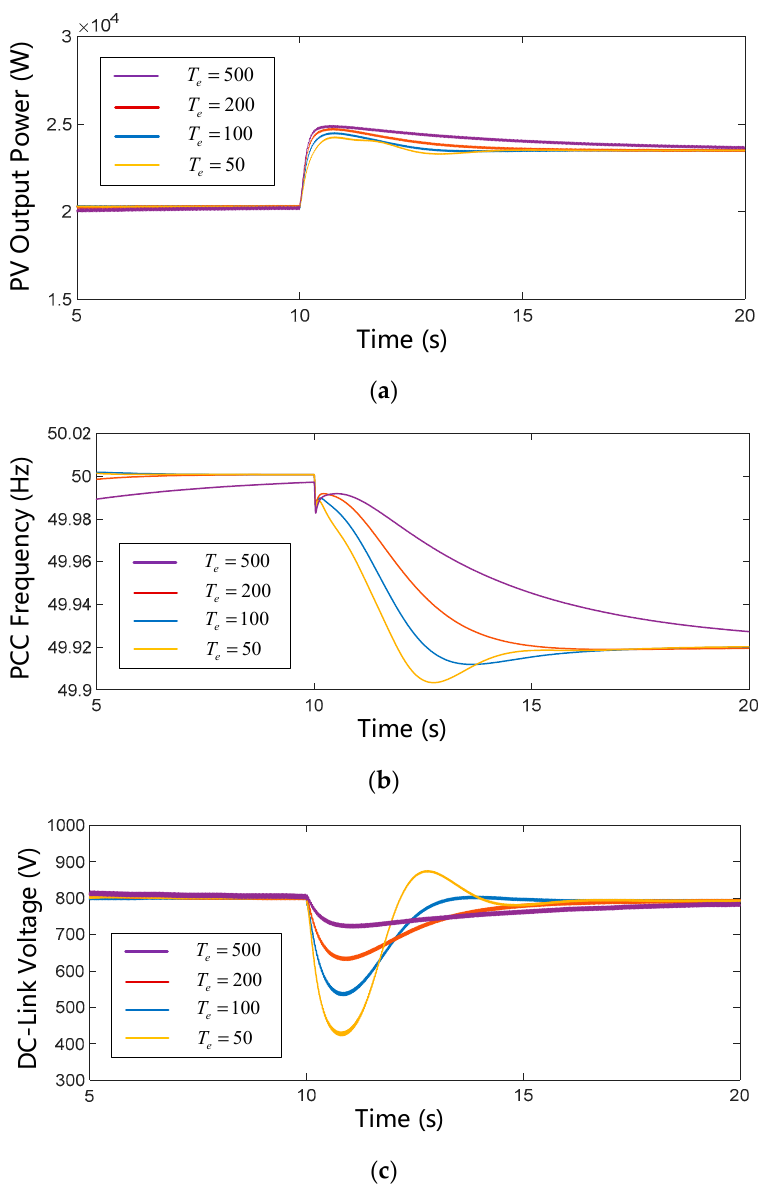
Figure 12. Simulation results of the proposed control method with different value of T e . ( a ) PV output power. ( b ) PCC frequency. ( c ) DC-link voltage.